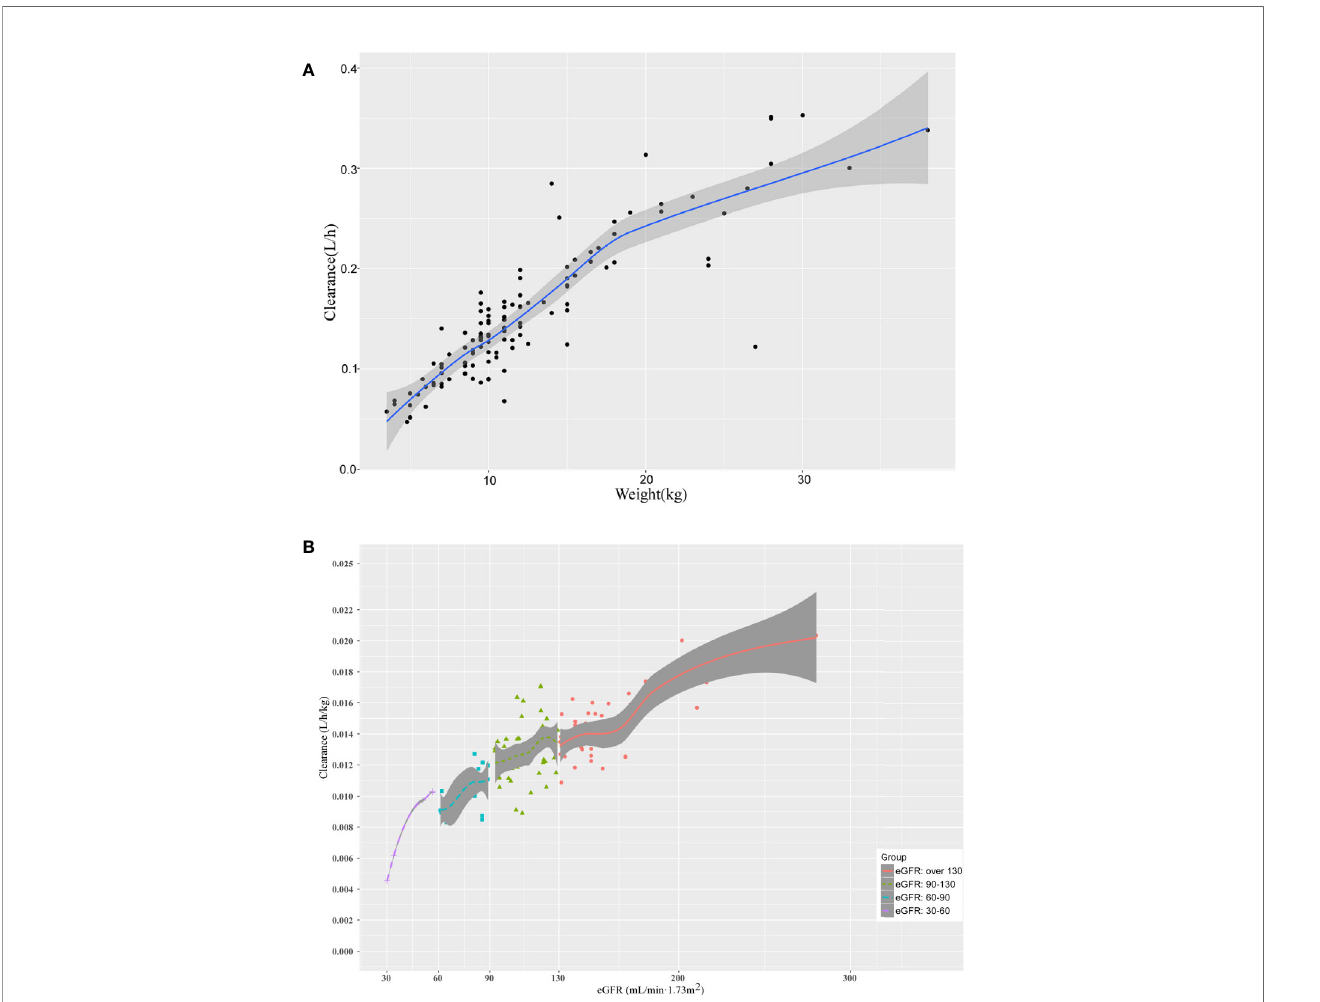
FIGURE 3 | The relationship between (A) the CL of teicoplanin and WT; (B) the CL of teicoplanin and eGFR for children with augmented renal function, normal renal function, mild renal insuf fi ciency and moderate renal insuf fi ciency. The shaded areas indicate 95% CIs for the locally weighted scatterplot smoothing fi t.